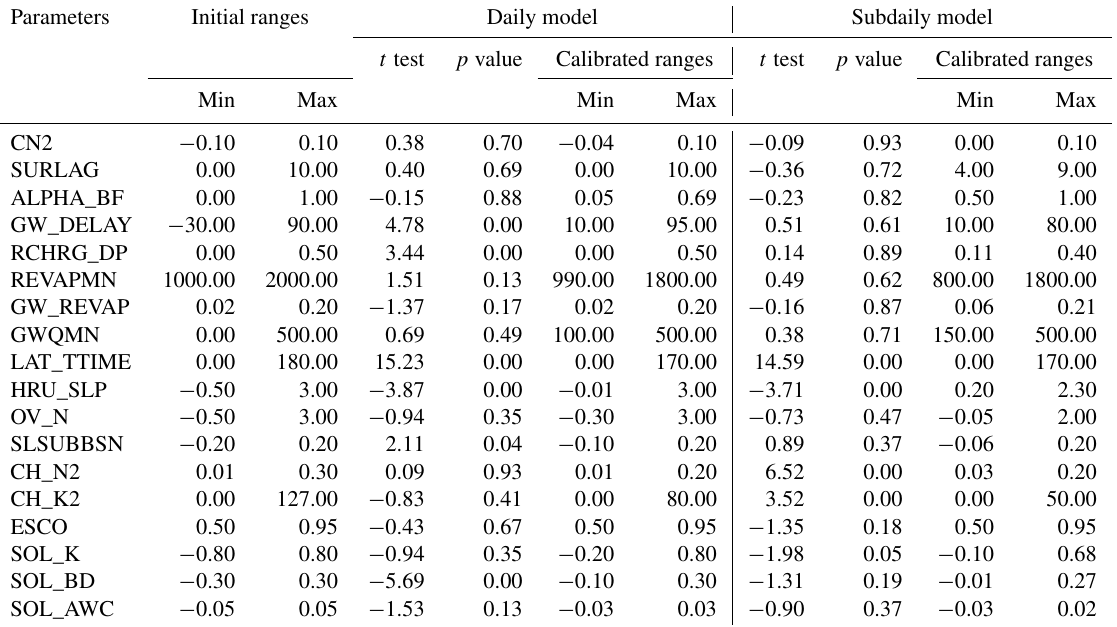
Table 4. Daily and subdaily SWAT-calibrated parameters and their sensitivities.